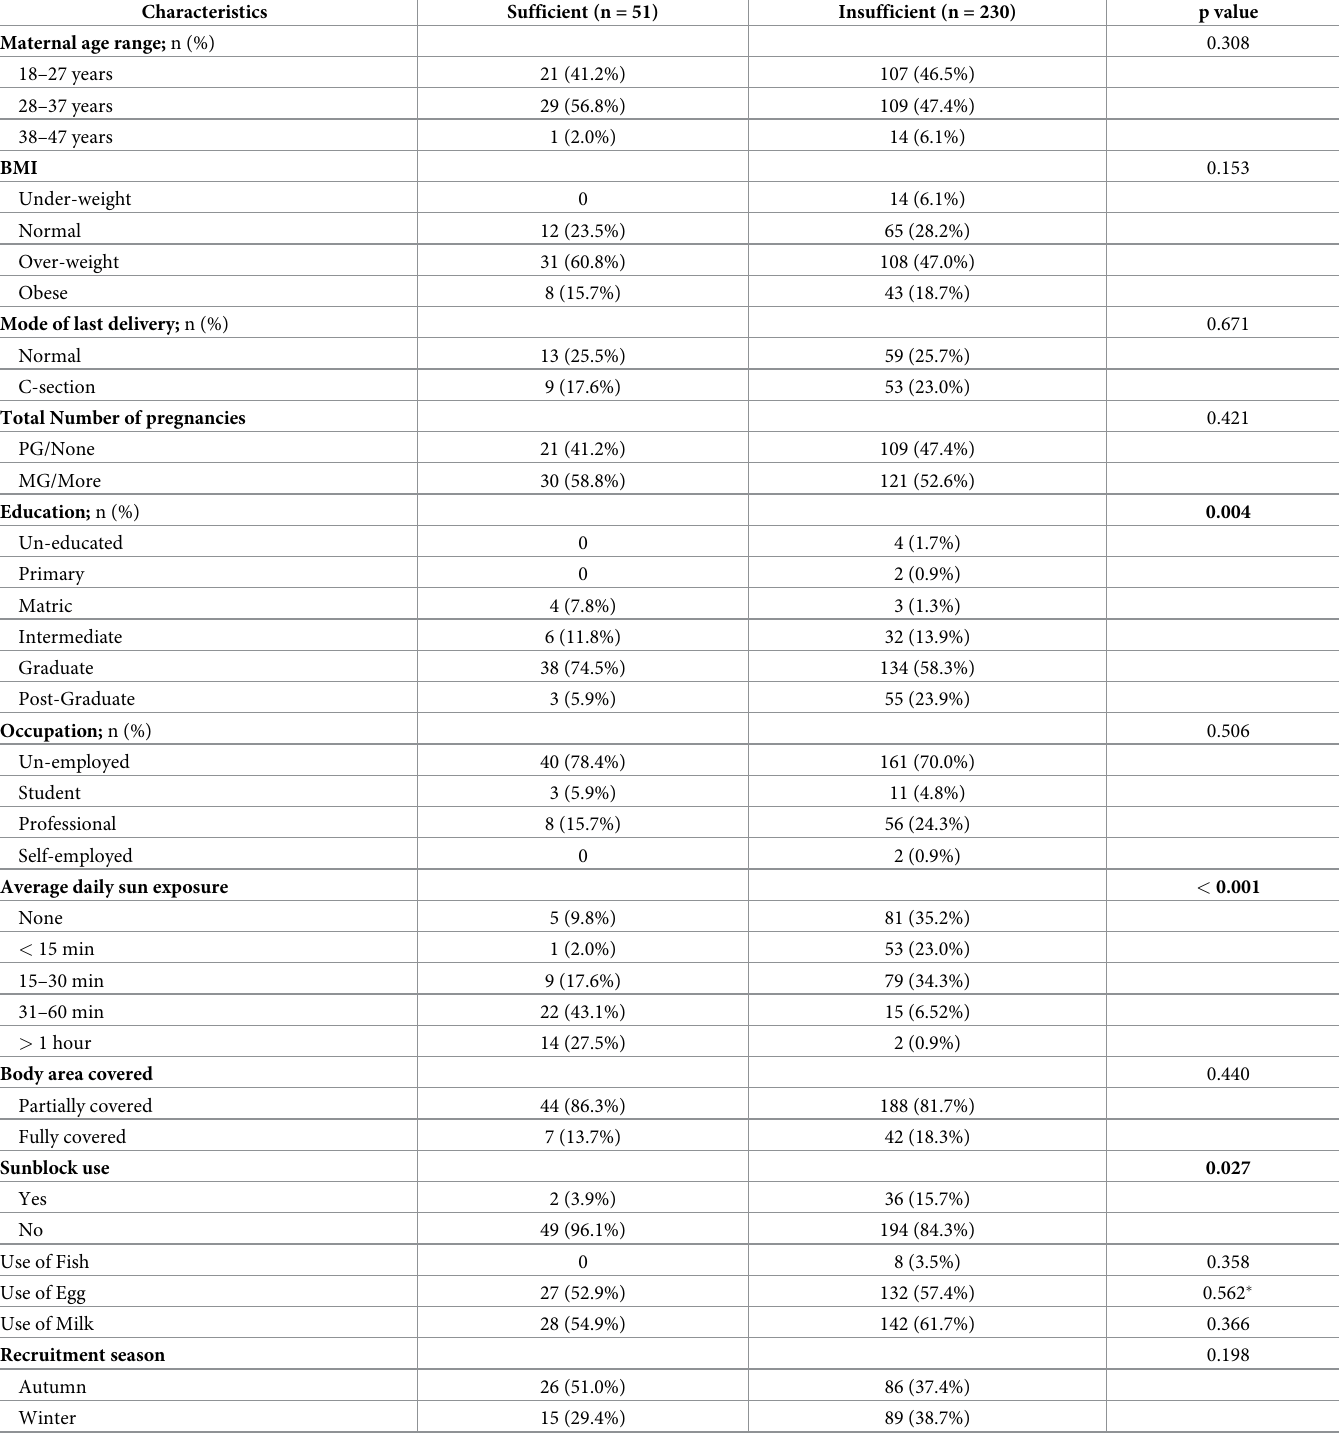
Table 5. Comparison between patients having sufficient and insufficient status of vitamin D at